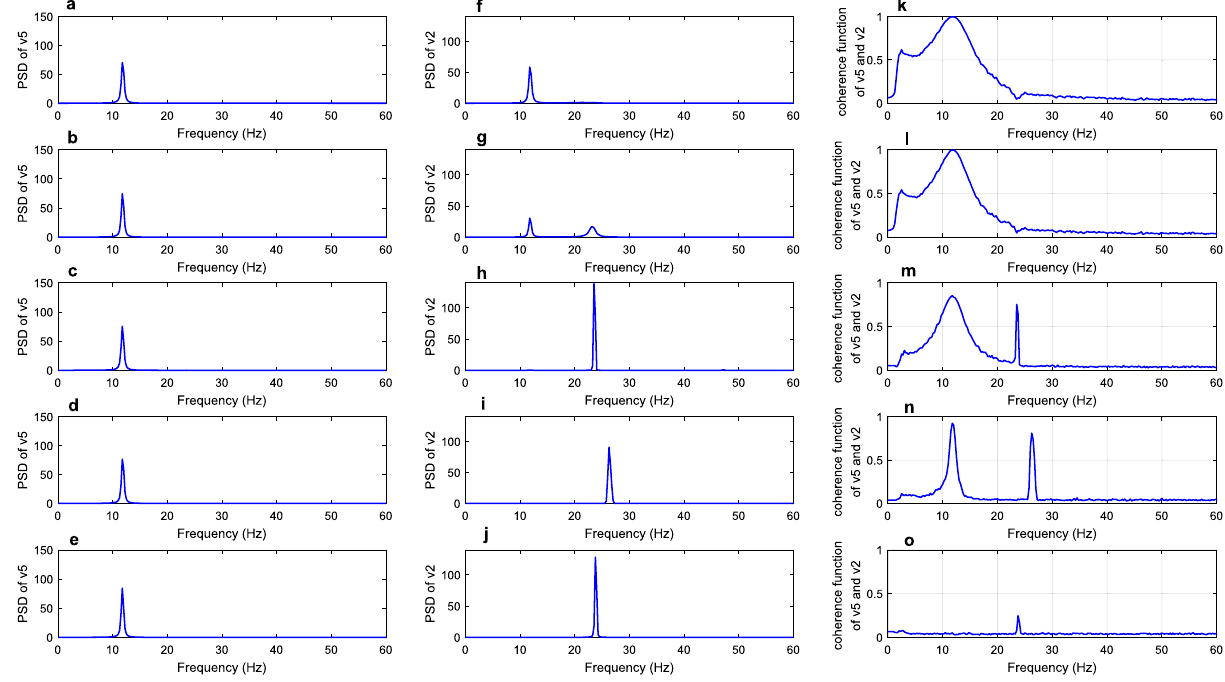
Figure 5. The first and second columns are PSD of areas v5 and v2, respectively. The coherence function between the two areas was delineated in the third column. From top to bottom, the parameters of long synaptic projection from v5 to v2 were in turn = 25, 20, 15, 5 and